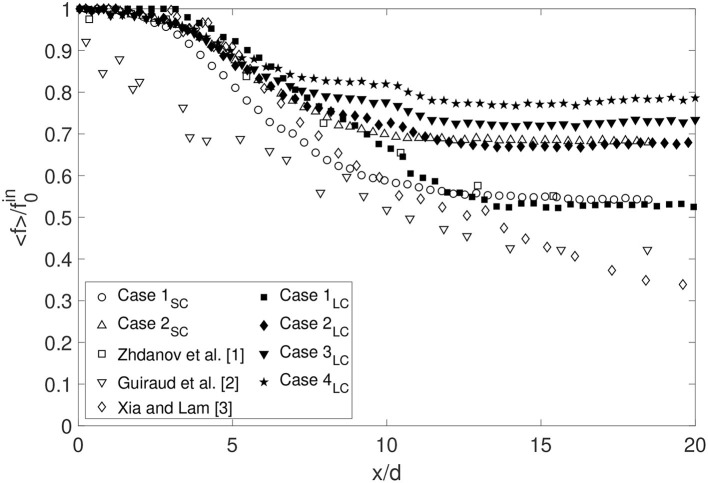
Comparison of the decay of the mixture fraction for rc = 0 for the small cannula (Case 1SC and 2SC) and for the large cannula (Case 1LC to 4LC) and also including some other studies (f0in corresponds to the averaged value of the mixture fraction on the cannula axis near its exit).